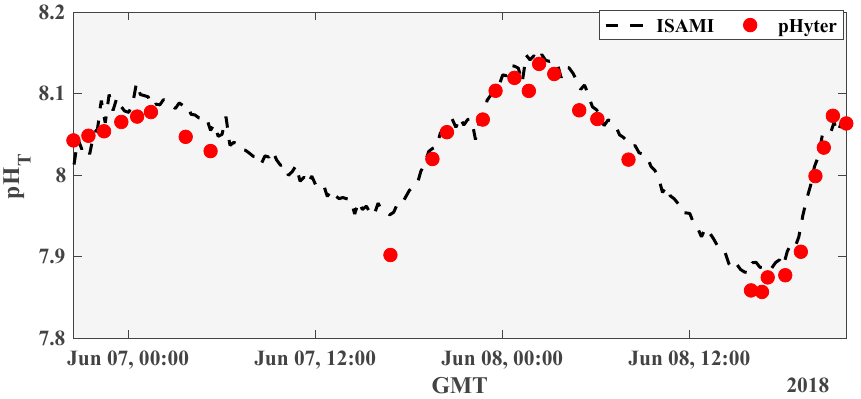
Figure 4. (pHyter and iSAMI pH measurements on a coral reef). pH measurements of back reef water in Tetiaroa, French Polynesia, over ~36 h. Data was collected continuously by the iSAMI (black dashed line) and periodically by the pHyter operator (red circles). The average difference between pHyter and iSAMI pH was − 0.033 ± 0.066.